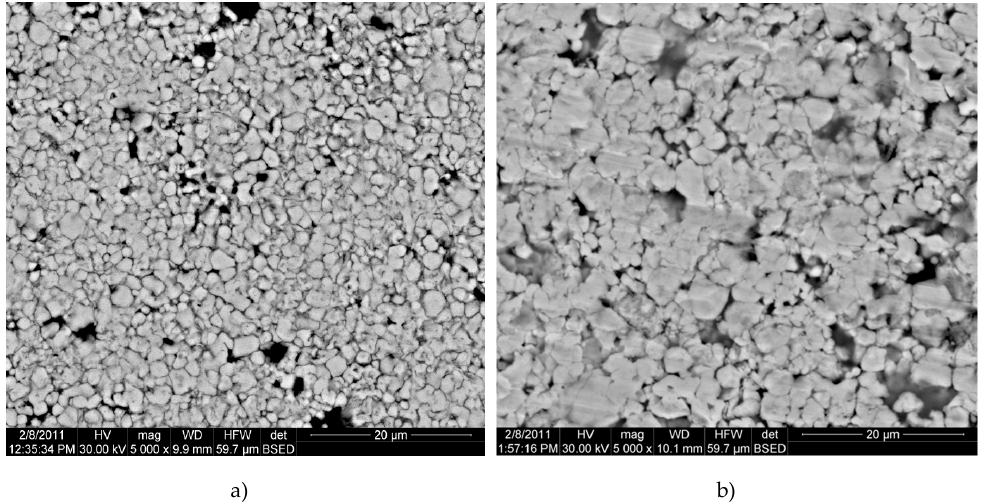
Figure 5. BSED microscopy images of the Cu-15%Fe 3 O 4 samples compacted at 500 MPa ( a ) and 700 MPa ( b ).